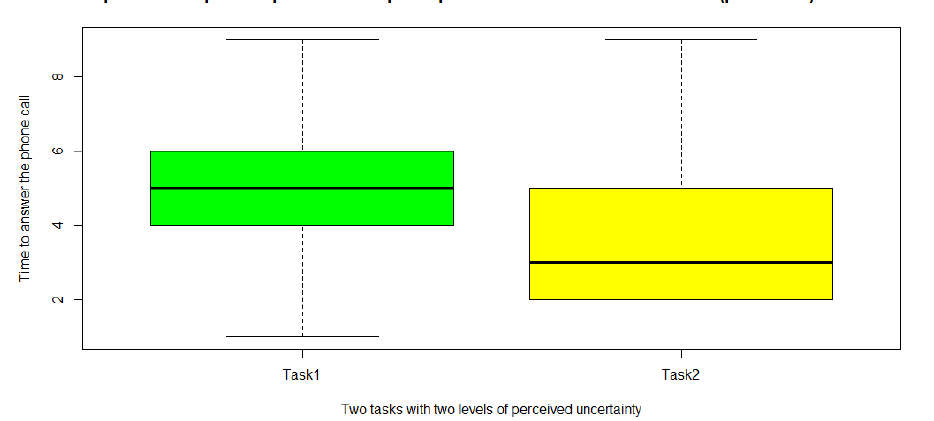
Figure 10. A comparison between the response time of the user to the source of information (the phone call) during Task 1 and Task 2, measured in [s].